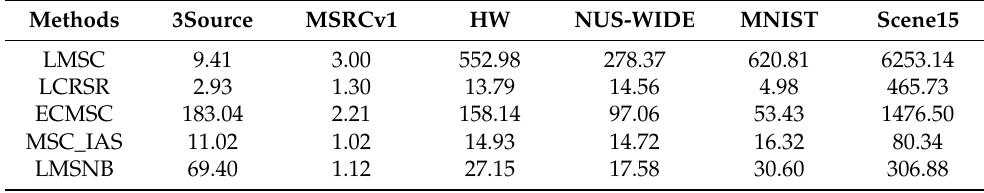
Table 5. The time consuming of different